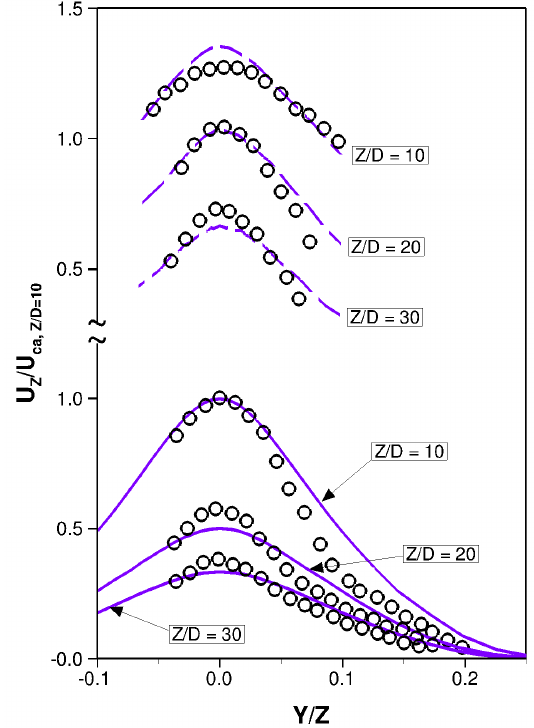
Figure 2. The comparison between normalized axial velocities resulted from simulation and experimental data [15]. Dashed line is the disperse phase, the solid line is continuum phase and symbols are experimental data observed by [15].